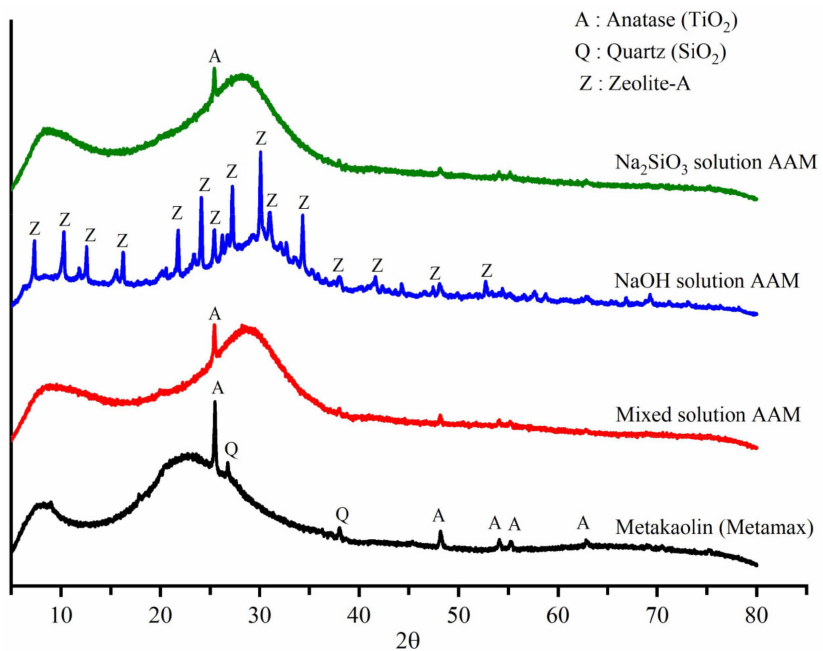
Figure 7. X-ray diffraction patterns of metakaolin and AAM samples produced using different alkali